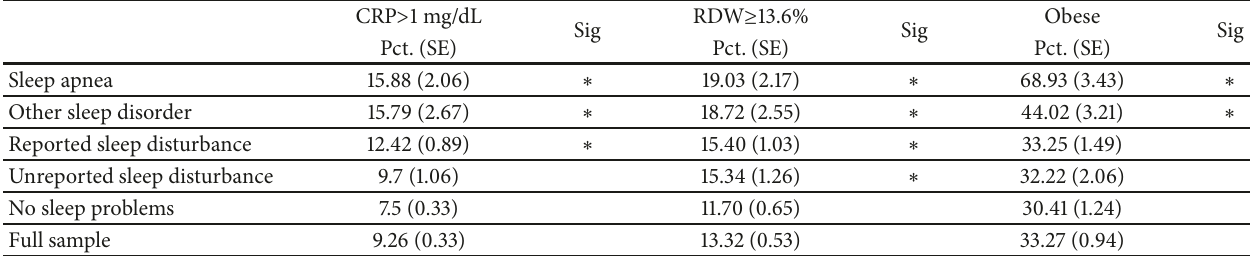
Table 2: Weighted percentages with CRP > 1 mg/dL, RDW ⩾ 13.6%, and obesity, by sleep